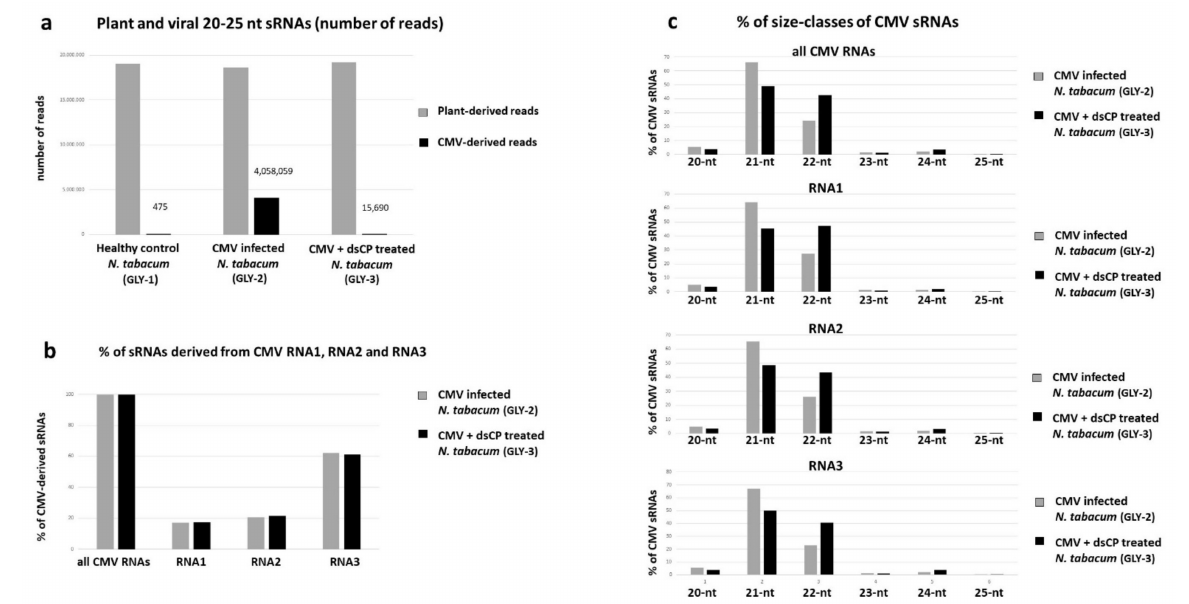
Figure 5. Illumina sequencing counts of endogenous and viral small RNAs (sRNAs) in healthy control (GLY-1), CMV- infected (GLY-2) and in vivo dsCP treated (GLY-3) tobacco plants. The 20- to 25-nt sRNA reads from GLY-1, GLY-2, and GLY-3 plants were mapped to the complete virus genome (CMV) or each of the individual CMV genomic RNA (RNA1, RNA2, RNA3) reference sequences with up to 2 mismatches and were counted. ( a ) The counts of CMV genome-derived 20–25 nt sRNA reads and total non-CMV reads in each library. ( b ) Percentage of each of the individual viral RNA-derived 20–25 nt sRNAs (RNA1, RNA2, RNA3) in the pool of the complete CMV genome-derived 20- to 25-nt sRNAs (CMV all). ( c ) Percentage of each size class in the 20- to 25-nt pools of the complete virus genome (CMV all)- and each genomic RNA (RNA1, RNA2, RNA3)-derived sRNA reads.